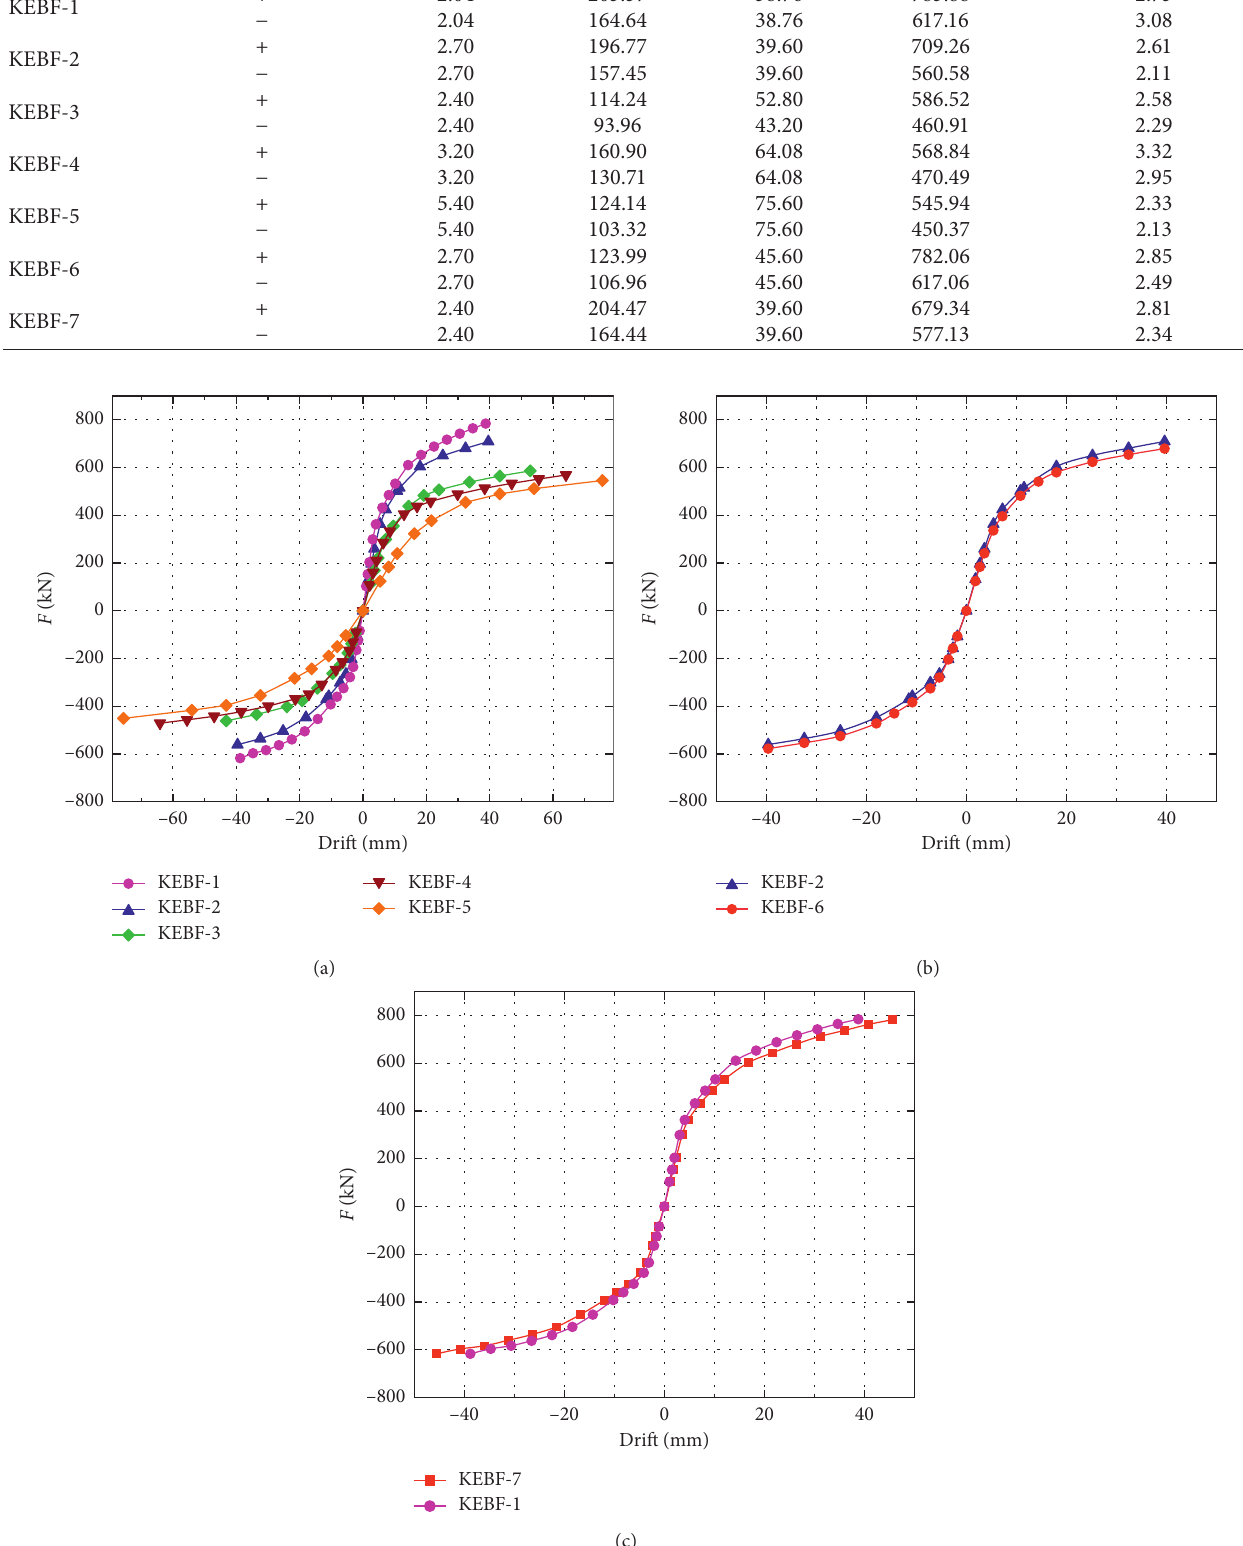
Figure 35: Skeleton curve of each